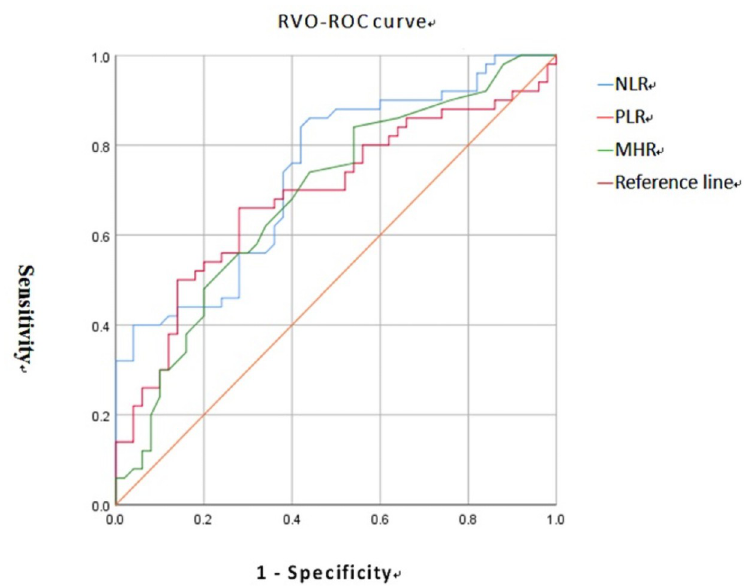
Fig 2. ROC analysis of NLR, PLR and MHR for